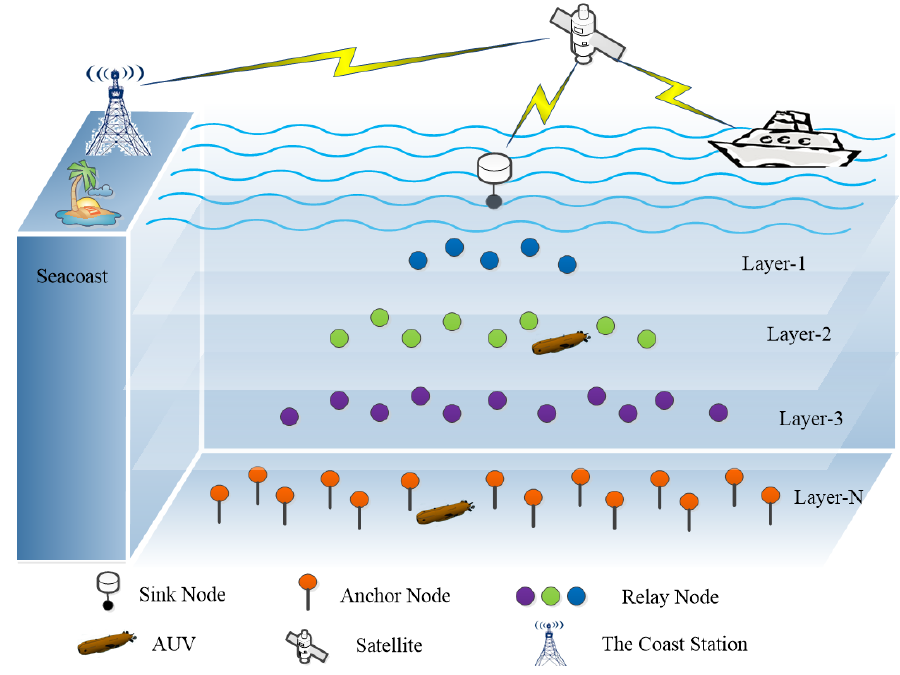
Figure 1. Network model of